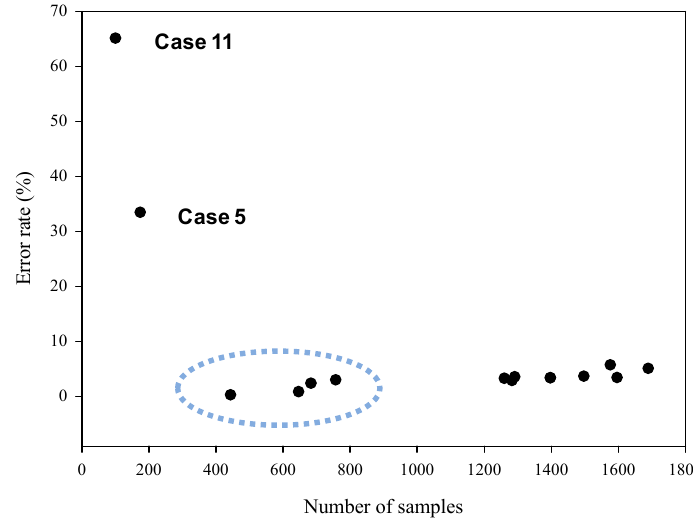
Figure 6. Error rates by the number of samples of various clustering types.